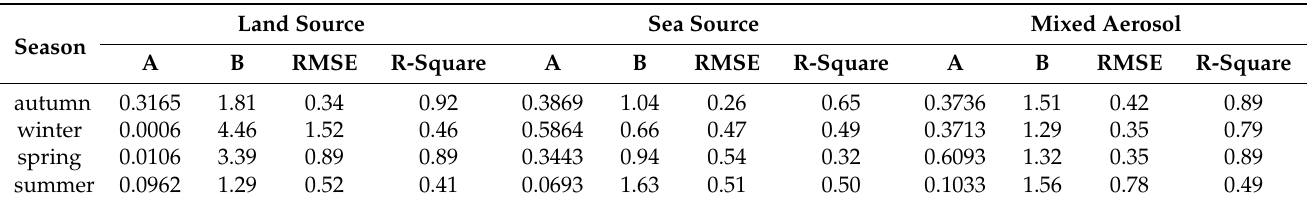
Figure 9. Seasonal HGF ext of different sources of aerosol in Qingdao from September 2019 to August 2020: ( a ) stands for autumn, ( b ) for winter, ( c ) for spring, ( d ) for summer. Table 4. Fitting parameters of HGF ext and evaluation indexes for each season